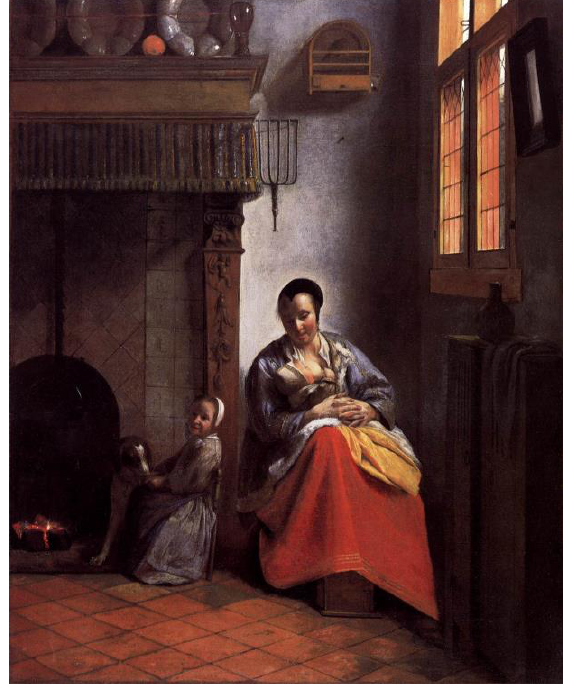
Figure 9. Pieter de Hooch, Mother Nursing with Child Feeding a Dog , circa 1658 – 1660. Fine Arts Museum of San Francisco.